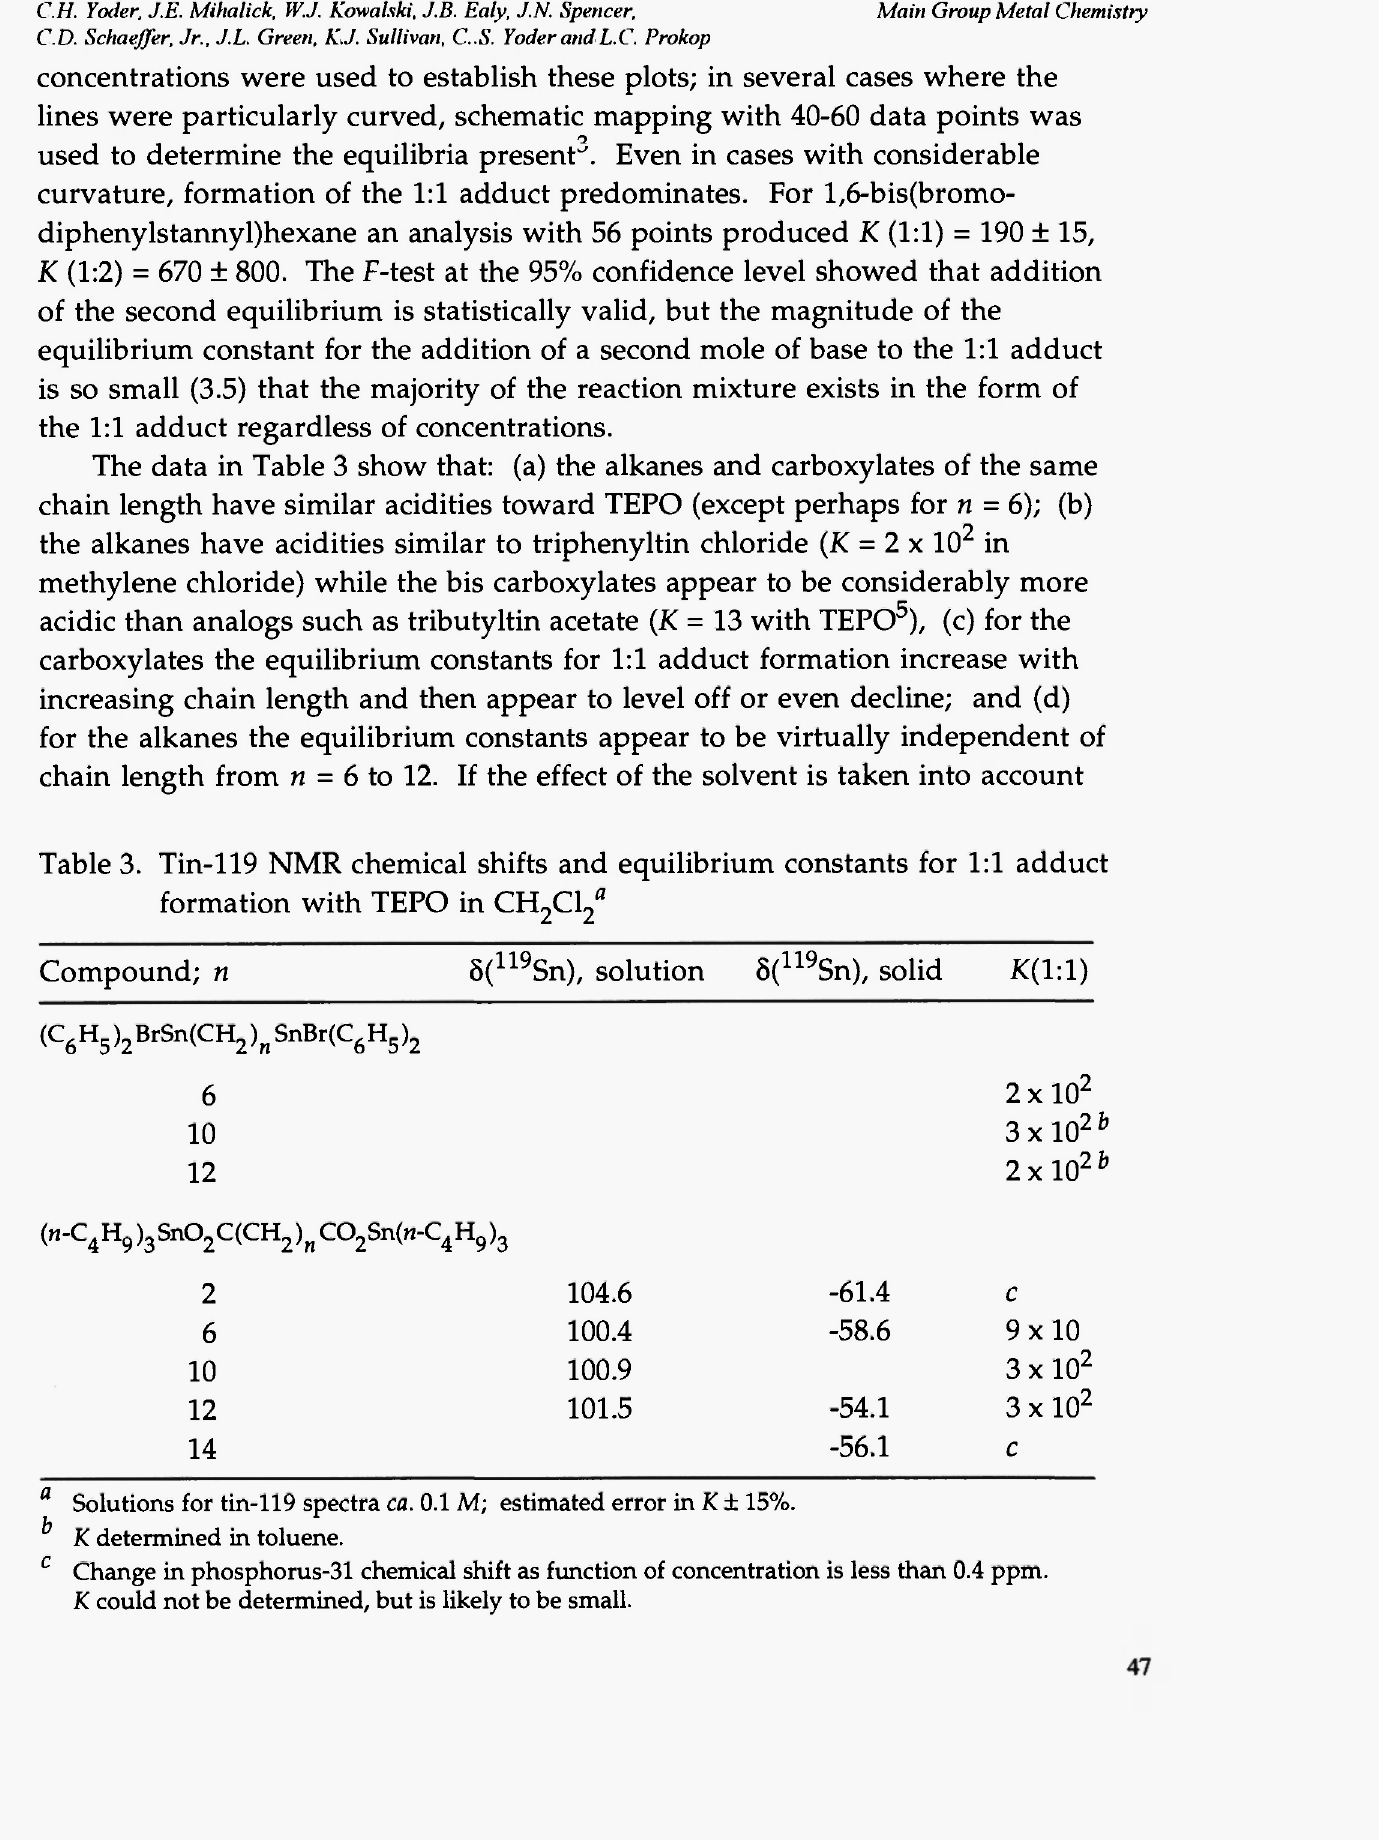
Table 3. Tin-119 NMR chemical shifts and equilibrium constants for 1:1